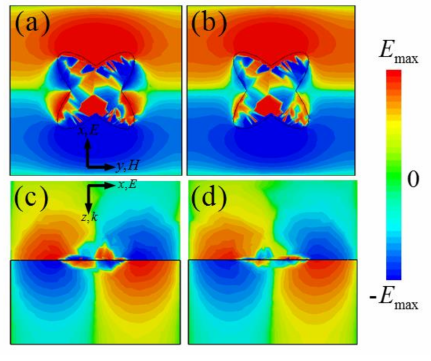
Figure 3. The electric field ( E z ) distributions of the x – y and x – z planes of the unit-cell structure at ( a , c )